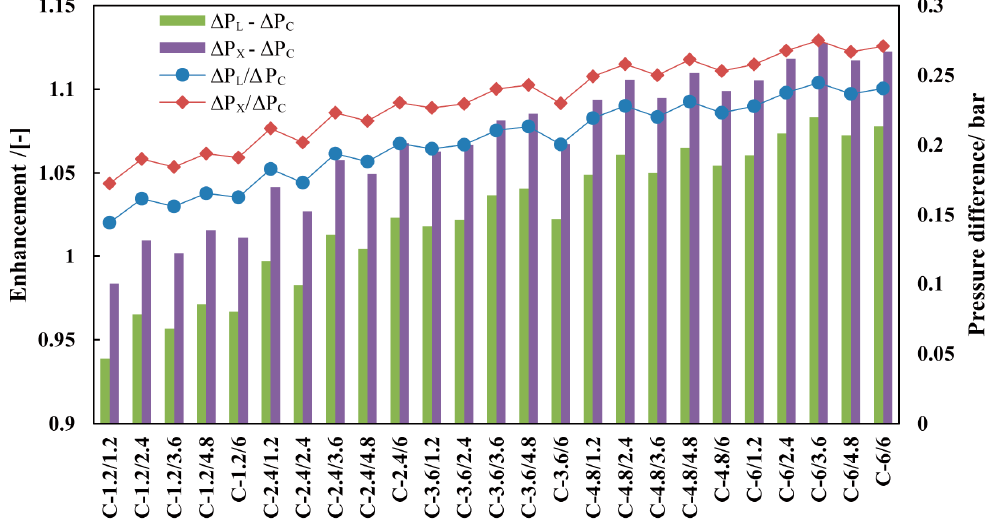
Figure 14. Improvement for C ‐ r i / r o compared to I ‐ X and I ‐ L (0.2 ≤ r ≤ 1).